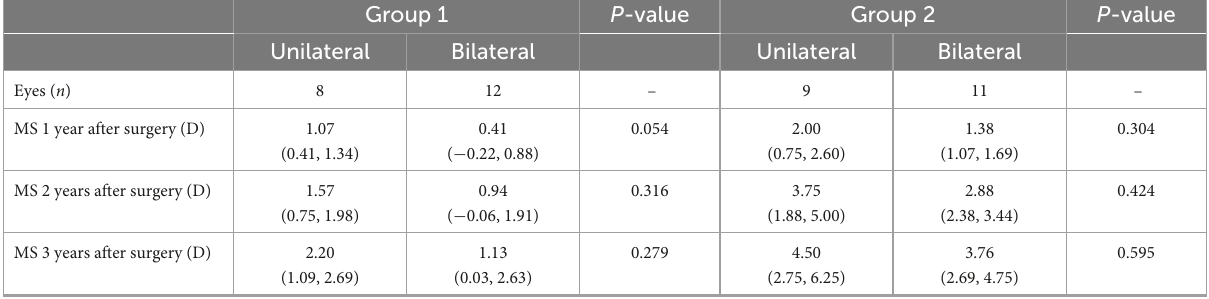
TABLE 3 Comparison of myopic shift (MS) in patients with unilateral and bilateral cataracts in the same pre-operative axial length (AL)